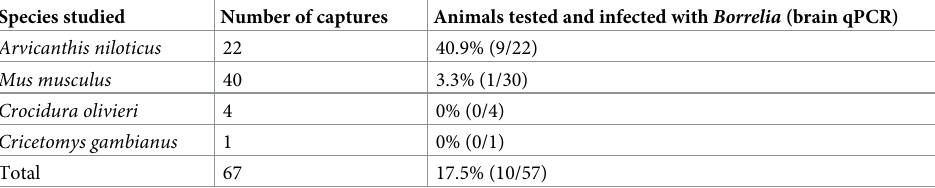
Table 3. Prevalence of Borrelia infection in small mammals collected in the Niakhar